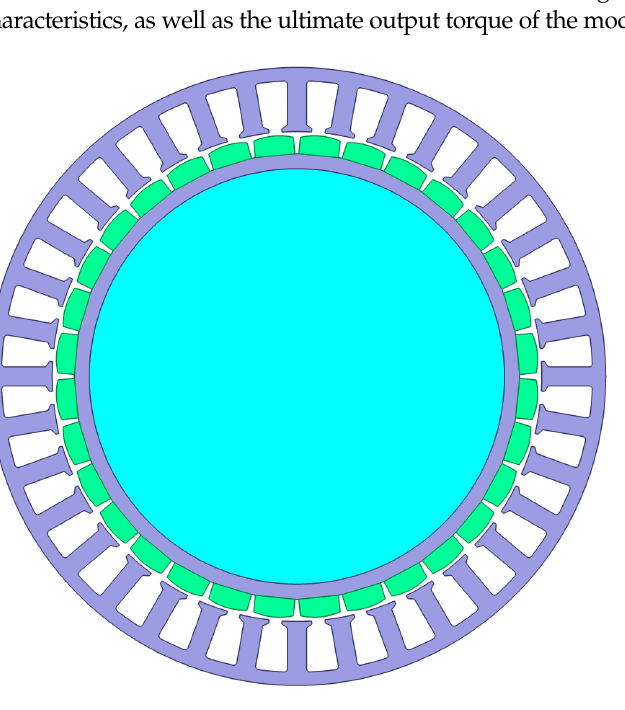
Figure 5. Cross section of the PMSM.